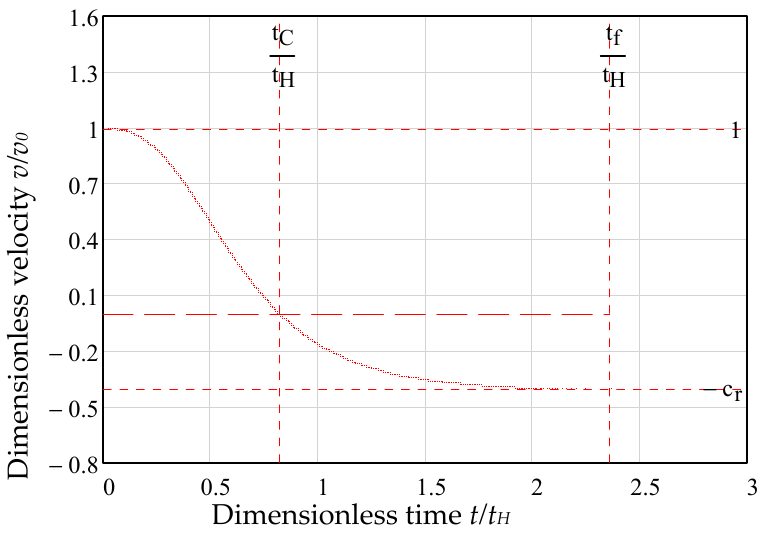
Figure 14. Variation of velocity with time. The time variations of forces are represented in Figure 15: the Hertzian (elastic) force, F Hz ; the damping force, F a ; and the total impact force, F . The work produced by these forces is represented in Figure 16. Moreover, during the restitution phase, the damping force is negative, and that is an attraction